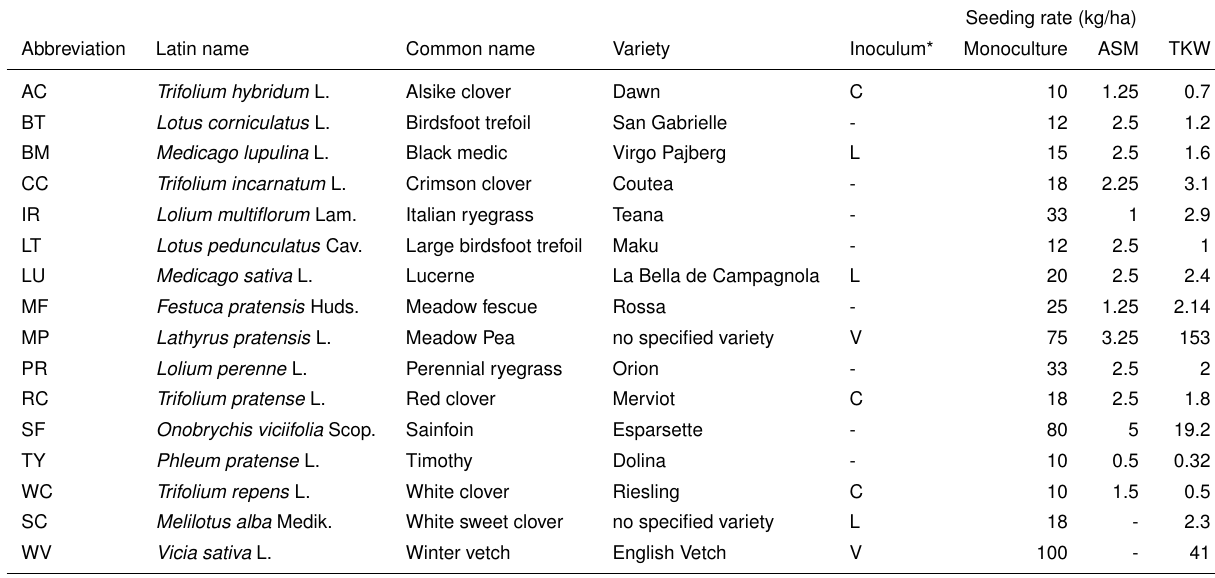
Table 1. Legume and grass species included in the trials: Latin and common name, variety, seeding rate (kg/ha), seed weight (Thousand Kernel Weight, TKW in g) and seeding rate in the monoculture plots and in the All Species Mix